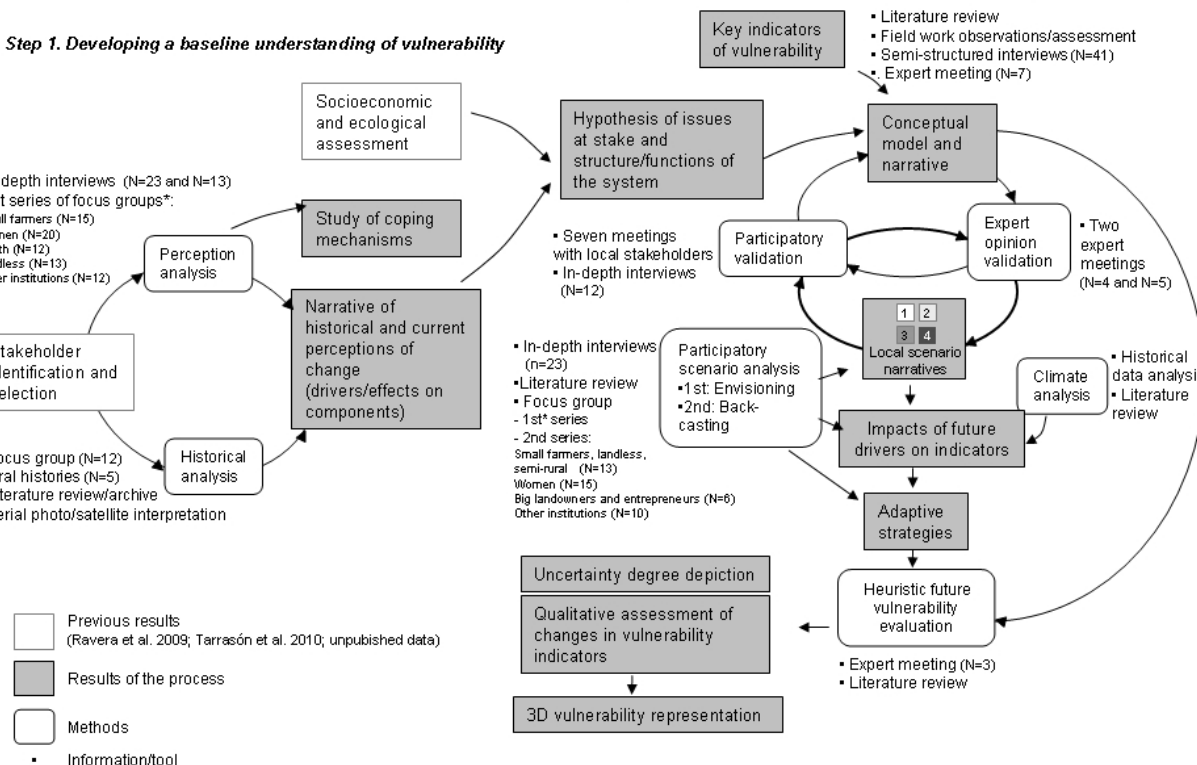
Fig. 2. Methodological framework for assessing vulnerability to